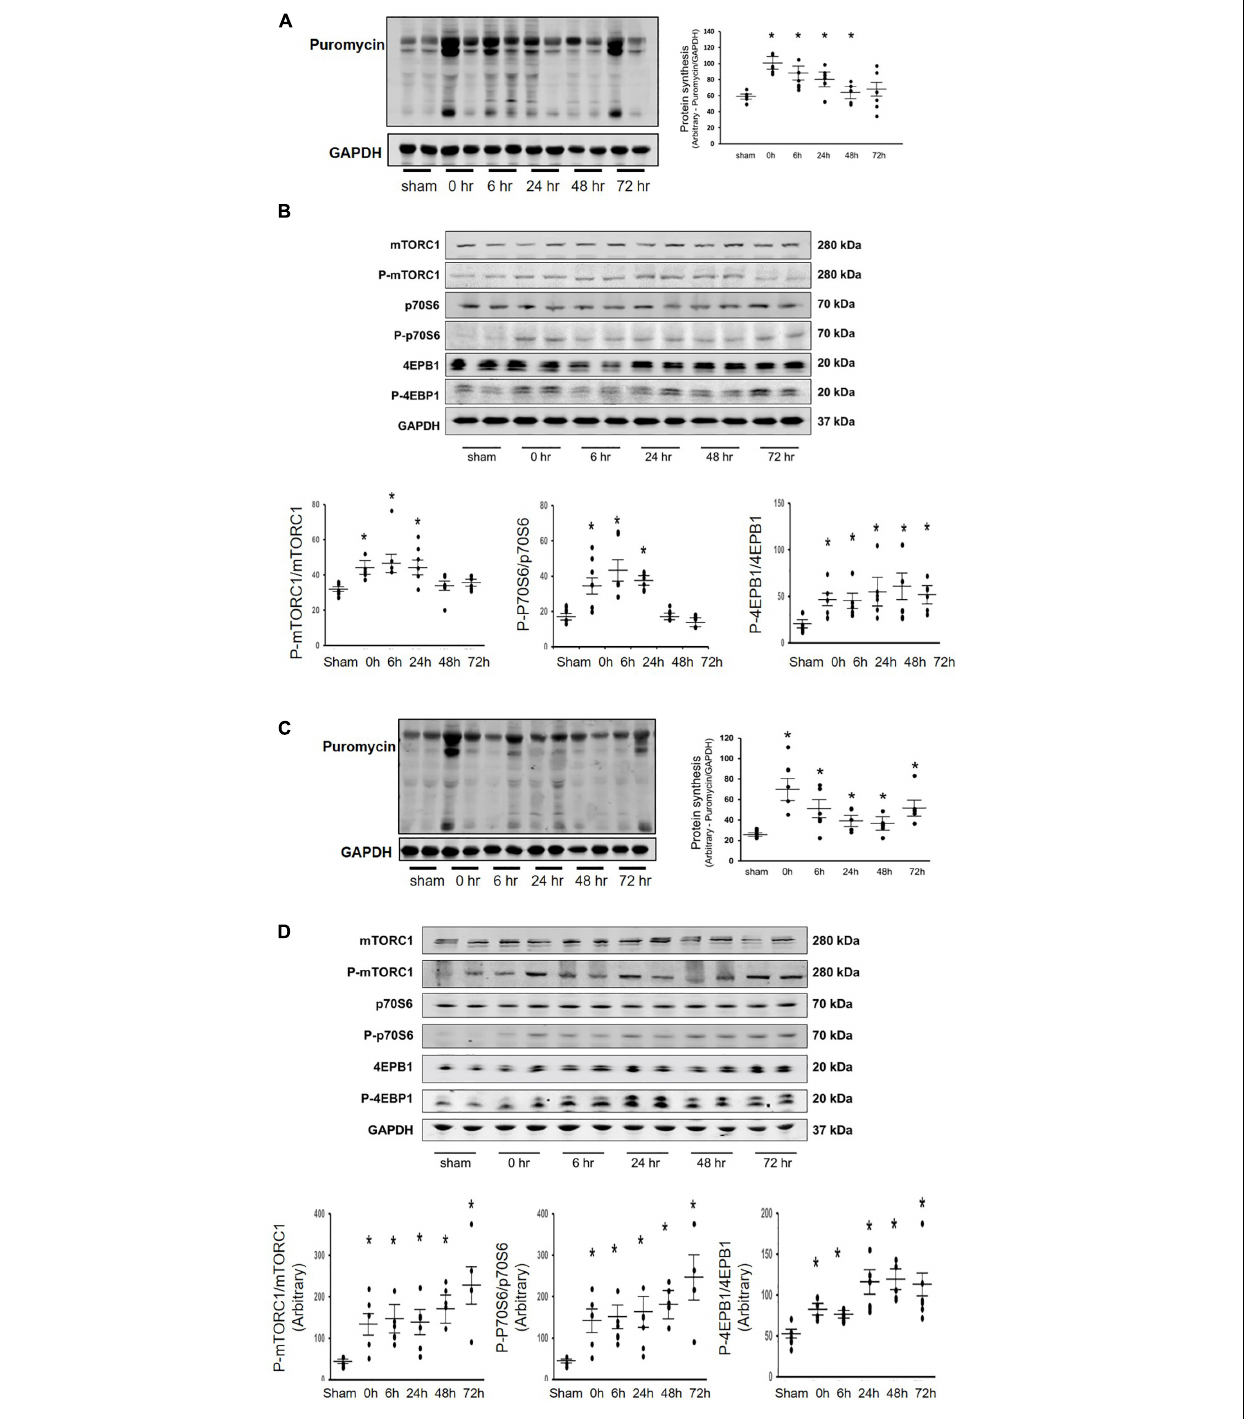
FIGURE 1 | Acu/LFES in hindlimb increased protein synthesis in both gastrocnemius and triceps brachii muscles. Experiments were performed in the sham and Acu/LFES treated mice. Puromycin was injected 30 min before harvest. Protein was isolated from the muscle of mice immediately (0), and 6–, 24–, 48– and 72-h after Acu/LFES. Puromycin in tissue lysates of gastrocnemius muscle (A) and triceps brachii muscle (C) was measured by Western blots. The point graphs show the change in incorporated puromycin normalized to their corresponding GAPDH protein ( n = 6/group; * p < 0.05 vs. sham). The proteins mTORC1, 4EBP1 and P70S6 were measured by Western blotting in gastrocnemius muscle (B) and triceps brachii muscle (D) of sham and Acu/LFES mice. The bottom point graphs show the ratio of phosphorylated protein to total protein, each normalized to the GAPDH from the same sample. Data is provided in arbitrary units ( n = 6/group; * p < 0.05 vs.